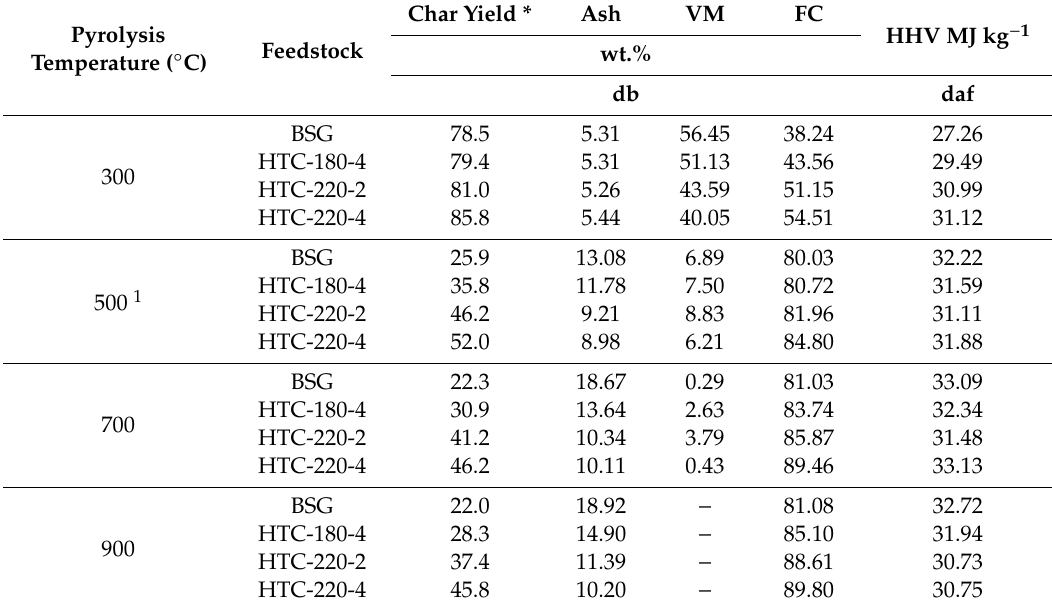
Table 2. Pyrolysis char yield and proximate analysis for brewer’s spent grains and hydrochars.